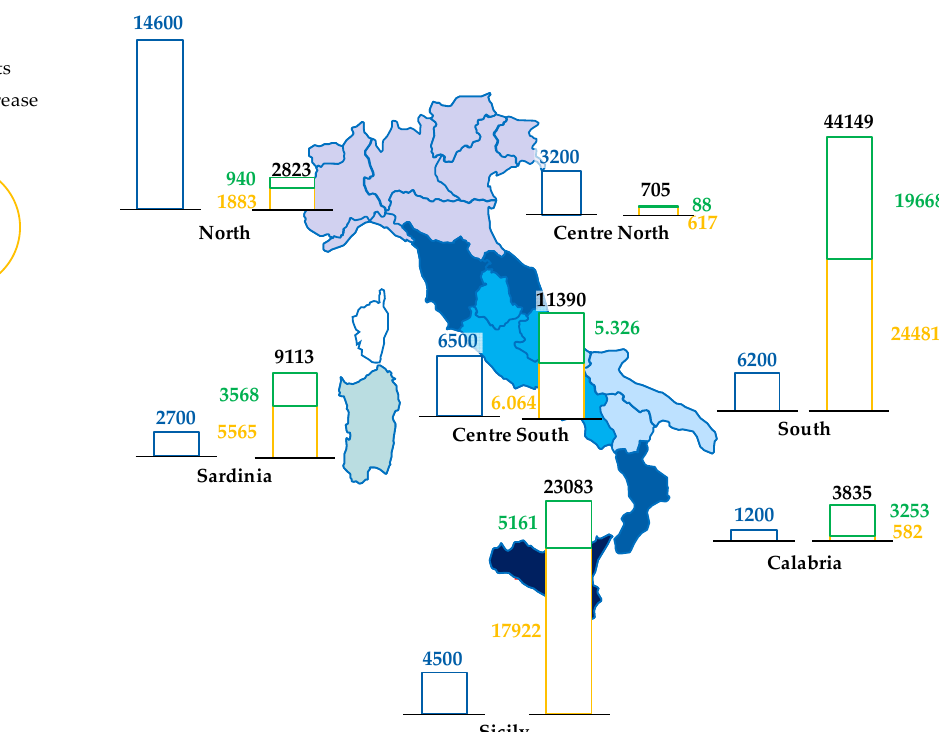
Figure 4. Comparison (MW) between the current national energy policy scenario RES increase forecast at 2030 year horizon (+39 GW at national level) and the present RES initiatives distribution (December 2020 update) in Italy. Regions of the same color belong to the same market zone of the Italian power system.